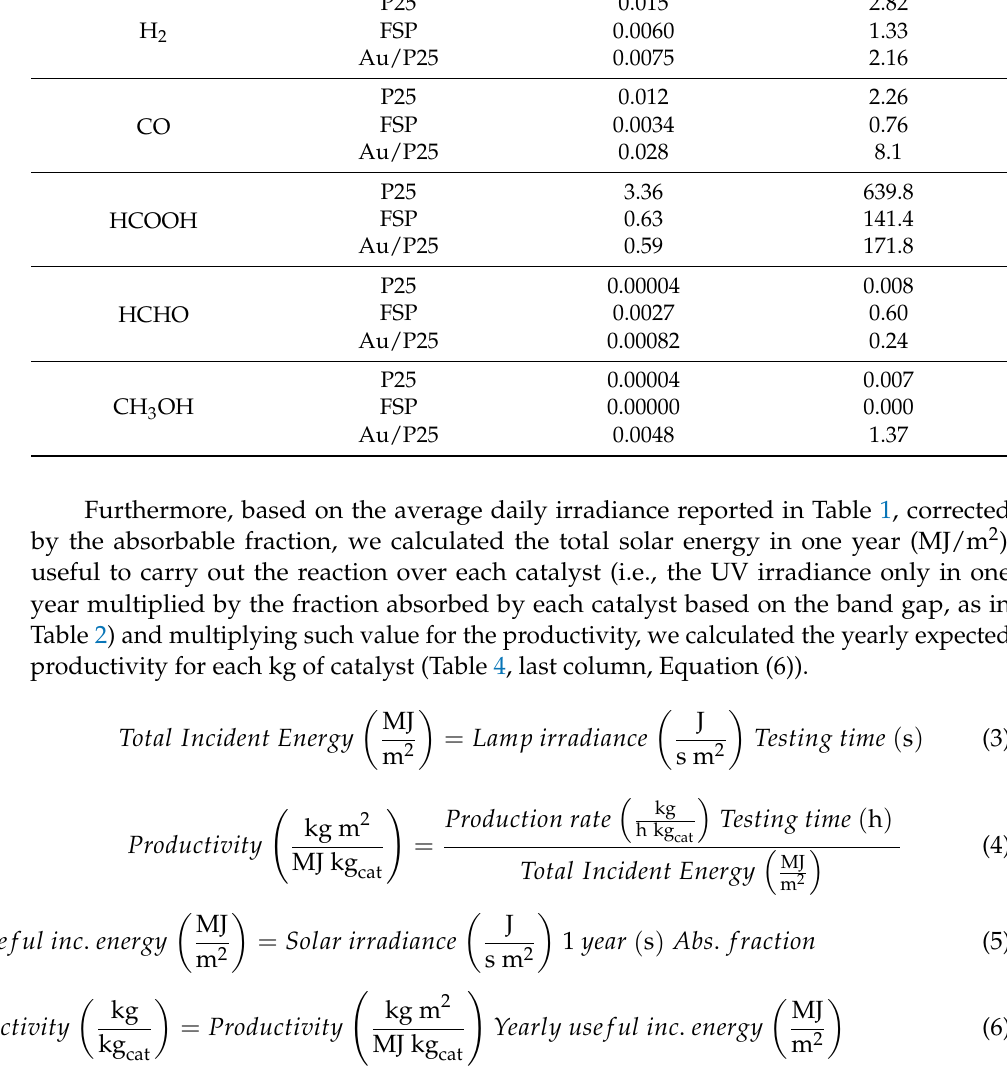
Table 4. Normalized productivity of different products, for different catalysts, normalized per kg of catalyst and per MJ/m 2 of incident energy. Yearly productivity expected based on solar irradiance corrected by the fraction of energy absorbed by each catalyst. Productivity (kg Compound Catalyst m 2 /MJ kg cat